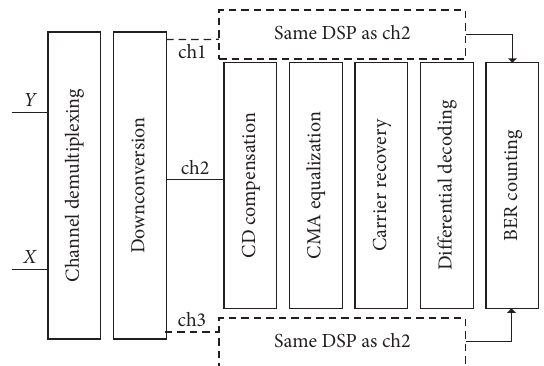
Figure 16: Optical multicarrier modulation DSP algorithm part of the